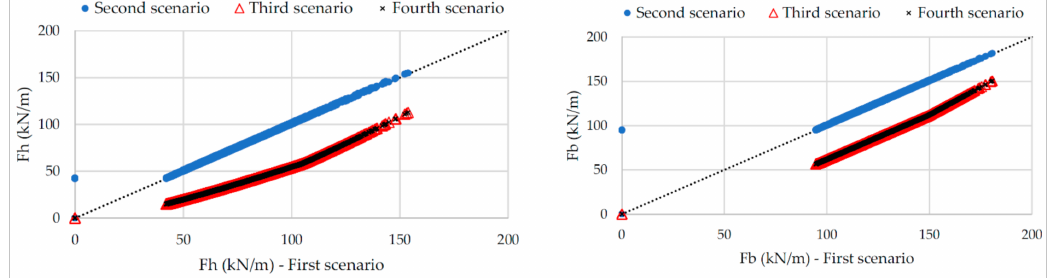
Figure 11. Horizontal and vertical forces for the first scenario compared with the second to fourth scenarios. As expected, minor changes are observed in horizontal and vertical forces to the sea level variation, while the maximum forces increase by less than 2% from scenarios 1 to 2 and from scenarios 3 to 4. The same happens with the momentum. With a change in the protection of the crown wall, and an area being unprotected, the differences are not as expected. In fact, the value of forces reduces as well as the correspondent momentum and the maximum of forces reduces by more than 25%. F h goes from a maximum of 153.8 kN/m (scenario 1) and 154.9 kN/m (scenario 2) to 112.8 kN/m (scenario 3) and 114.1 kN/m (scenario 4). This happens because the reduction in A c in scenarios 3 and 4 does not correspond a reduction in the value used for the authors to calculate dynamic pressure. This value depends on the difference between R u and A c . R u is only a function of the wave height and ξ , not depending on A c , making a reduction in A c lead to an increase in dynamic pressures and consequently, on forces and momentum.